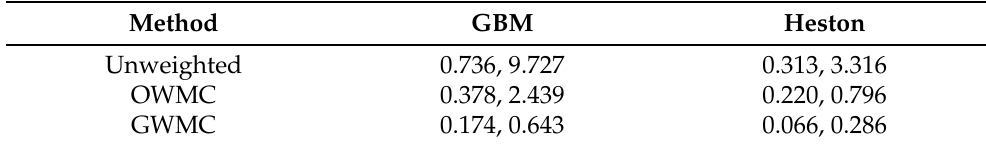
Table 4. Aggregate results for the out-of-sample cross-sectional performance for the two different initial models along with the two different weighted calibration methods, as well as the unweighted versions for comparison. The first and second number in each column are the average MRPE and MAPE, respectively, for the entire